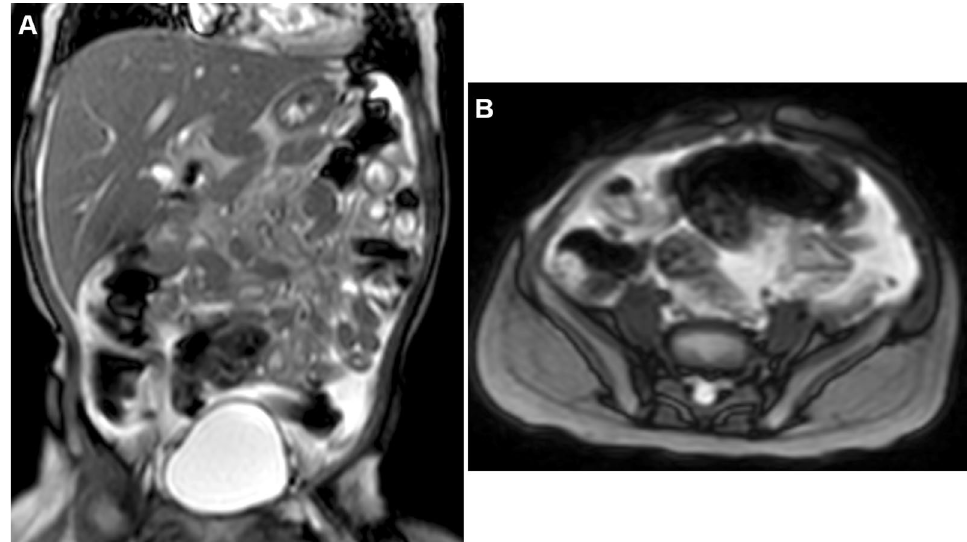
Fig. 6 A 6‑month‑old boy was referred for routine follow‑up. A , B Abdomino‑pelvic T2 SPIR in coronal and axial planes, respectively, shows large volume of free ascites (CSF ascites). The cranial portion of this shunt is patent (not shown). This patient experienced increasing occipitofrontal circumference during regular follow‑up visits (1.5 months after imaging), and he underwent an alternative CSF diversion (VA shunt insertion)